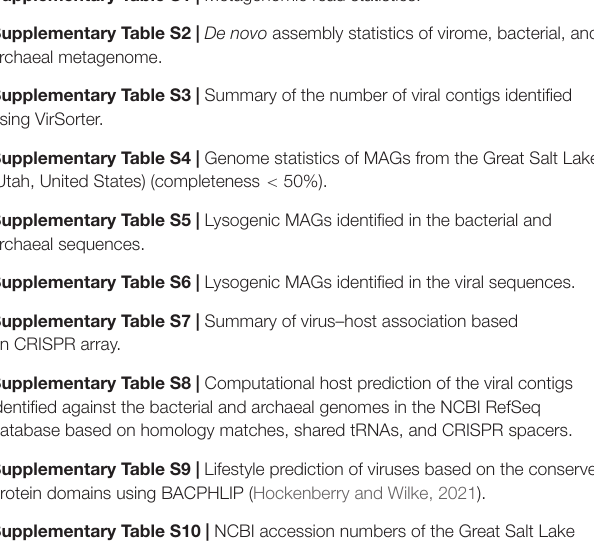
Supplementary Figure S1 | Vertical profile of physio-chemical data (specific conductivity, dissolved oxygen and oxidation–reduction potential) in three Great Salt Lake (GSL) study areas [ (A) CB2, (B) GSL 3510, (C) GB14]. Supplementary Figure S2 | Workflow schematic of the viral, bacterial, and archaeal metagenome analysis. Supplementary Figure S3 | Genome map of viral genomes (contigs) identified from the Great Salt Lake sediments with auxiliary metabolic genes (AMGs). The AMGs are denoted by asterisk ( ∗ ). Arrow length in the genome maps is proportional to the size of the open reading frame (ORF). Supplementary Figure S4 | Taxonomic profiling of the bacterial and archaeal communities in sediments across the Great Salt Lake in (A) Kingdom, (B) Class, (C) Order, (D) Family, (E) Genus, and (F) Species level. Supplementary Figure S5 | Relative abundance of lysogenic MAGs represented by bar graphs. Supplementary Figure S6 | Number of CRISPR arrays and spacer sequences in bacterial and archaeal contigs (per million reads) across the Great Salt Lake. Supplementary Figure S7 | Association of CRISPR spacers from the bacterial and archaeal contigs with the viruses from the marine, saline, and hypersaline aquatic ecosystems (extracted from IMG/VR database). Supplementary Figure S8 | Comparison of relative abundance between bacteria and archaeal phyla (based on bacterial and archaeal metagenome reads) with viruses that infects them (based on the Virus–Host database) across the Great Salt Lake sediments. Supplementary Table S1 | Metagenomic read statistics.